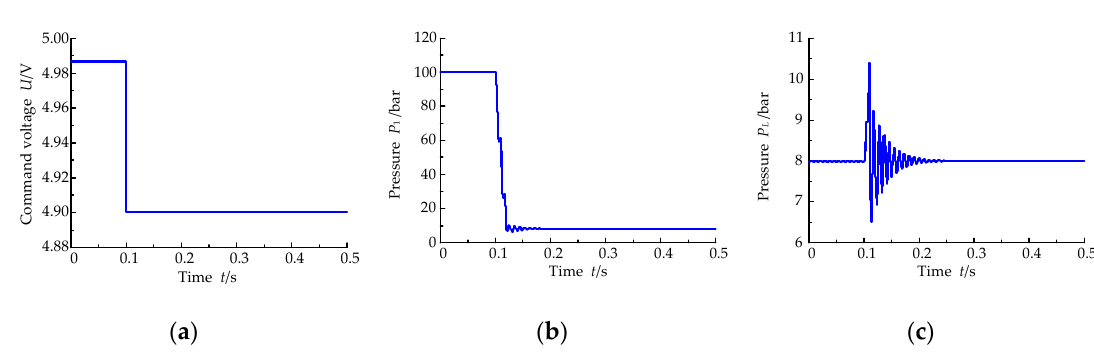
Figure 3. The simulation curve under the step pressure-relief rule. ( a ) Eccentric magnitude; ( b ) Working cylinder pressure; ( c ) Relief-pipe pressure.